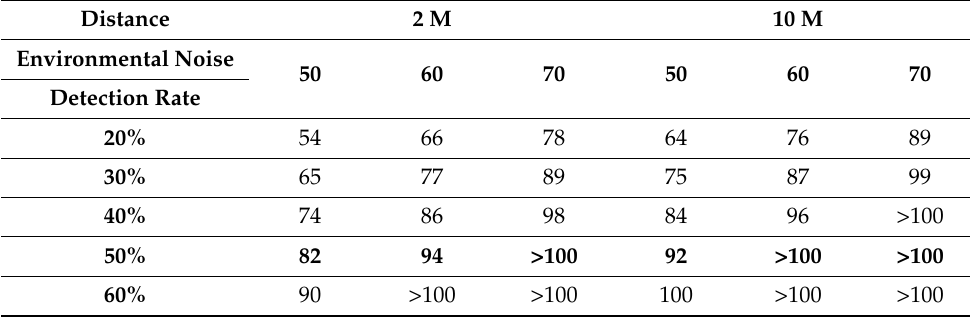
Table 5. Estimated SPL (dBA) of low-frequency warning